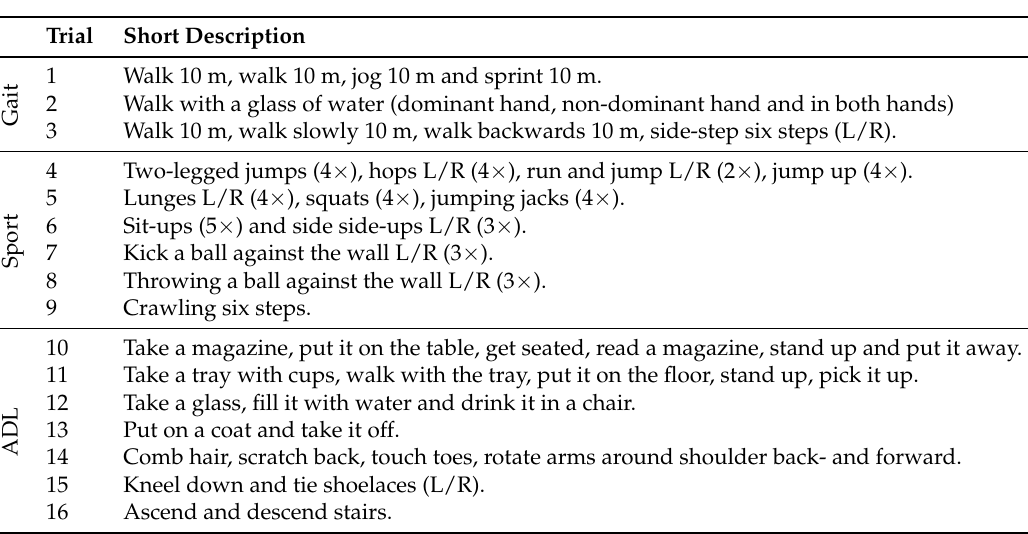
Table 1. A description of trials in the experimental protocol (each trial was performed three times by all subjects). ADL = Activity of Daily Living, L = left and R =